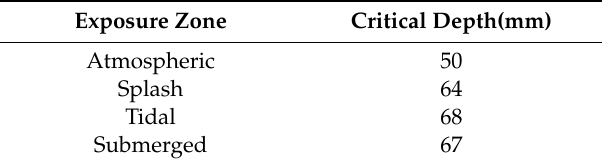
Table 3. Critical depth calculated using Equation (24).